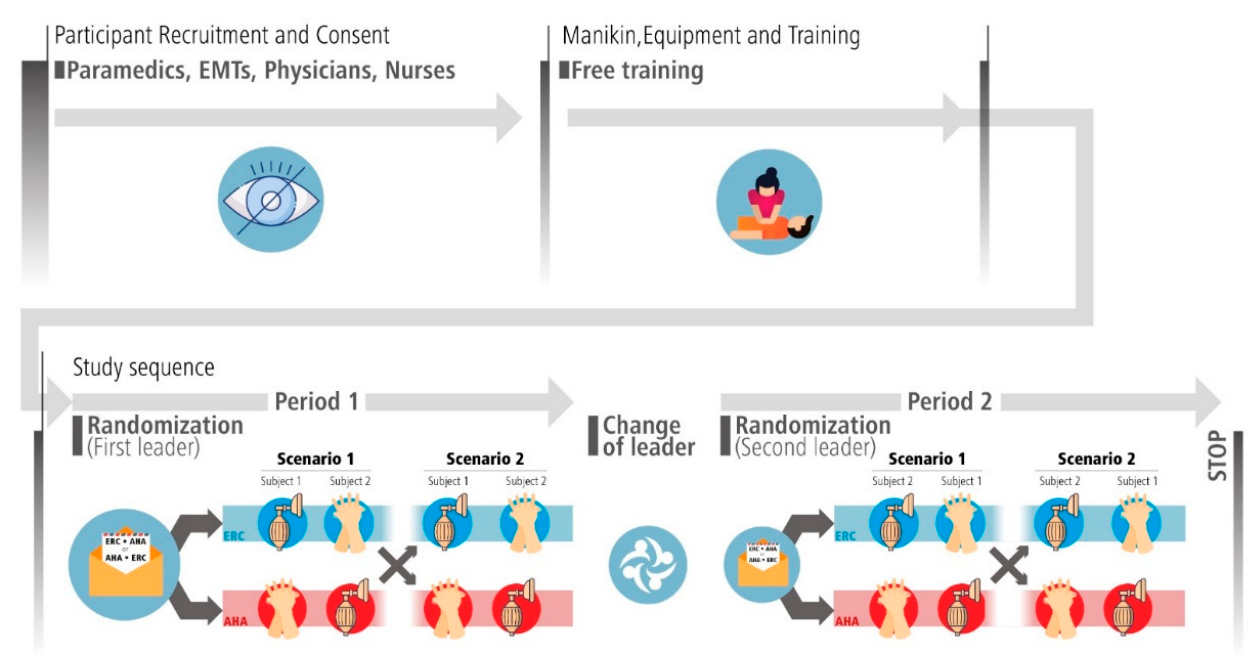
Figure 1. Study sequence. Teams of two participants will first train on a manikin identical to the one used to collect data. After entering the study room, the first leader will pick an opaque, sealed envelope, and carry out two resuscitation sequences according to the allocation. Team members will then switch roles. The new leader will then pick another envelope and perform the two last resuscitation sequences